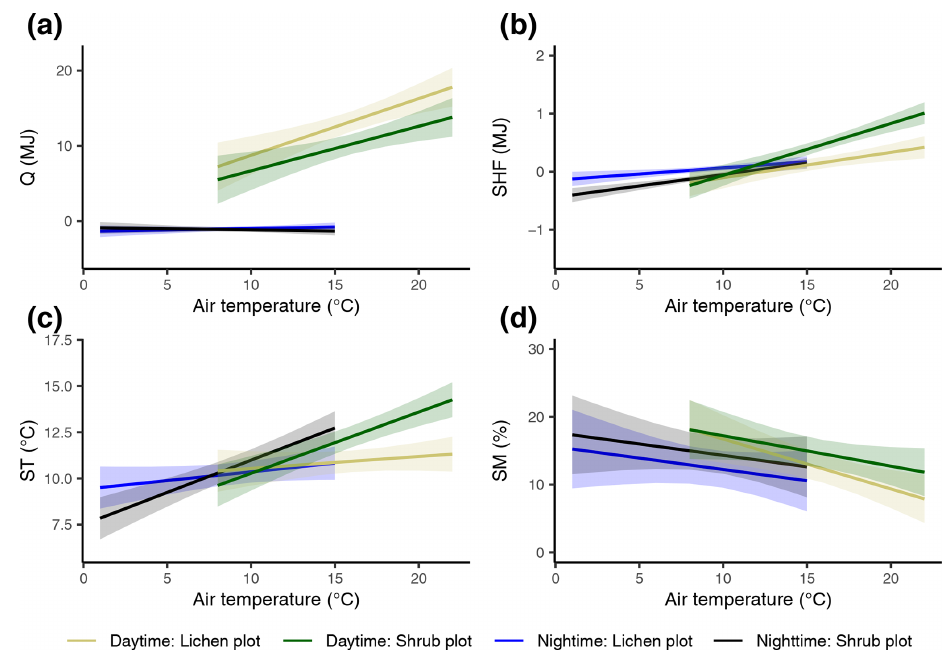
Figure 7. The modeled relationships with 95% confidence intervals between vegetation type, average reference air temperature and total net radiation (a) , total soil heat flux (b) , average soil temperature (c) , and average soil moisture (d) during daytime and nighttime. See Appendix C for details on the mixed